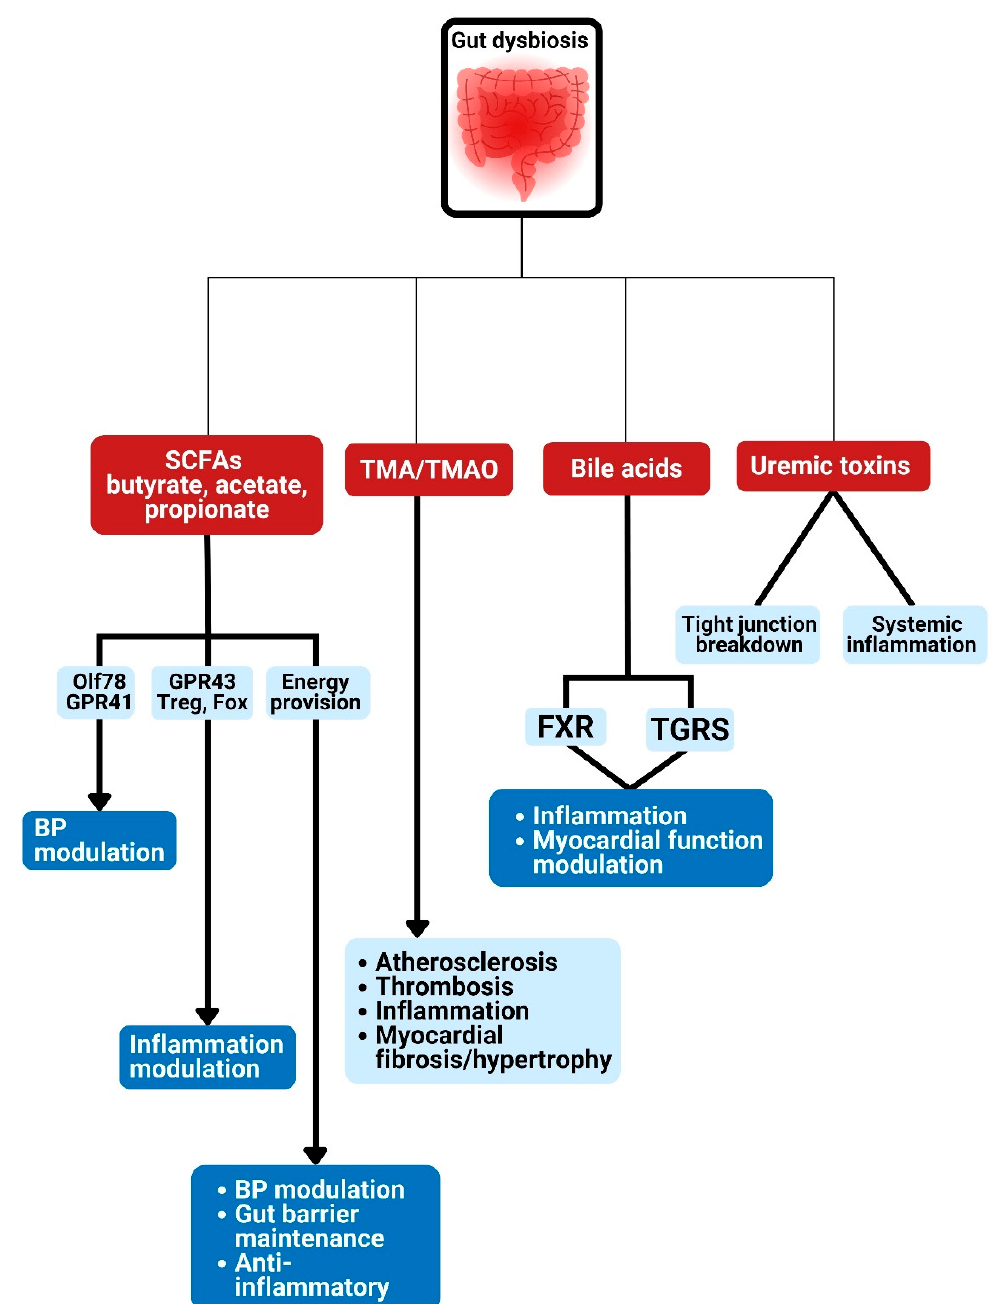
Figure 3. Gut dysbiosis and potential metabolism-dependent pathways linked to cardiometabolic diseases. Gut microbiota are linked to various CMD developments via the production of metabolites such as bile acids, short-chain fatty acids, trimethylamine- N -oxide production, and uremic toxin. SCFA: short chain fatty acids; TMA: trimethylamine; TMAO: trimethylamine N -oxide; GPR: G-protein–coupled receptor; Olfr78: olfactory receptors; BP: blood pressure; FXR: farnesoid X receptor; TGRS, G-protein-coupled bile acid receptor.